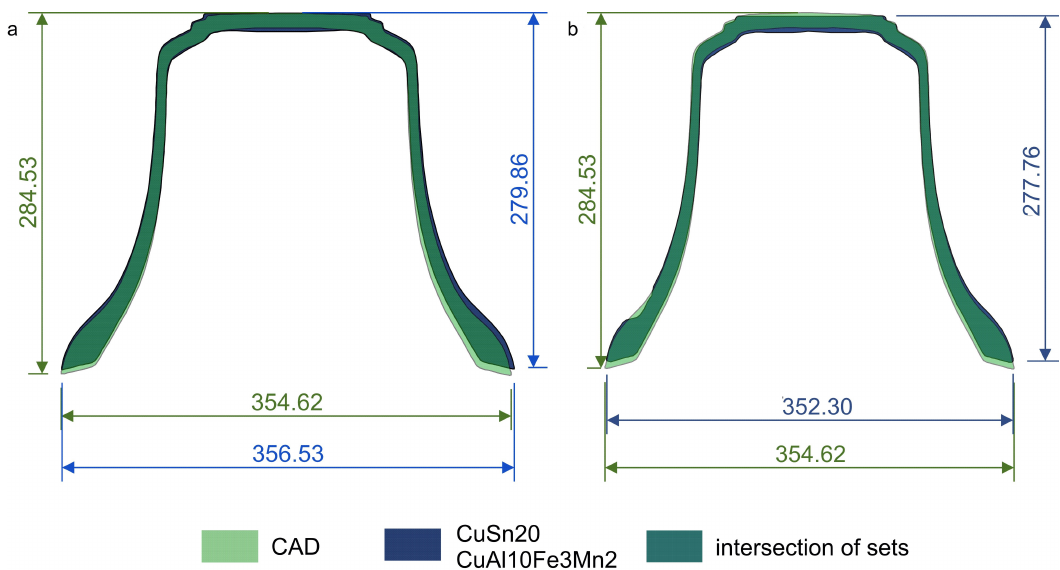
Figure 8. Assessment of the correctness of the selected shrinkage: ( a ) CuSn20; ( b )